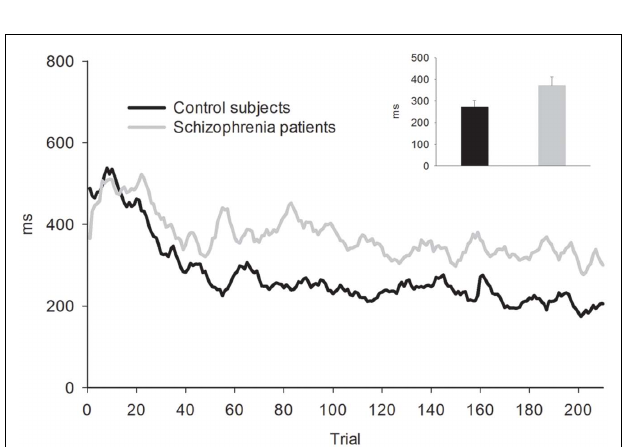
FIGURE 2 | Five-trial running average of absolute RT deviation from target RT for the time estimation task. Bar graph shows mean of absolute RT deviation. Error bars indicate